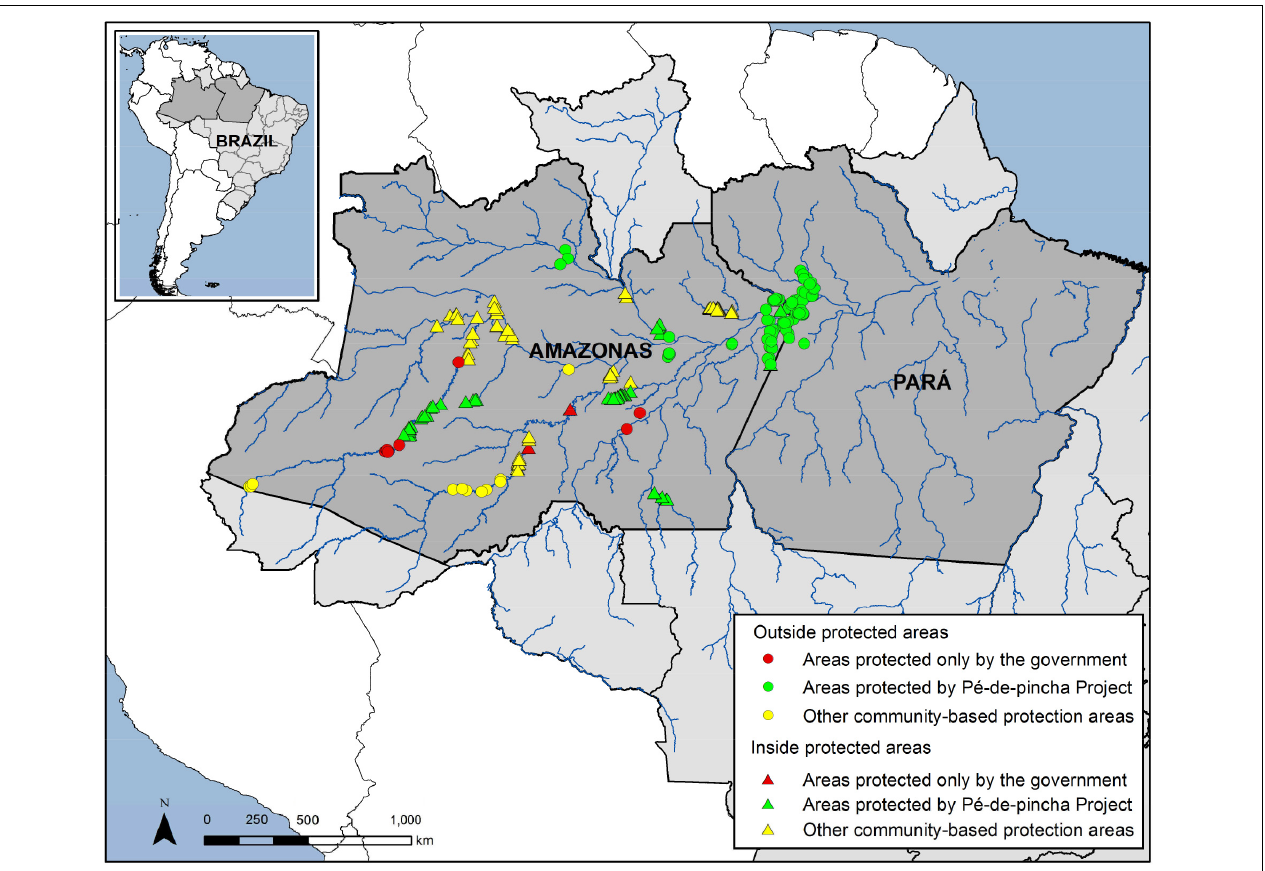
FIGURE 1 | Chelonian conservation areas in the Amazonas state and the northwestern section of the Pará state,